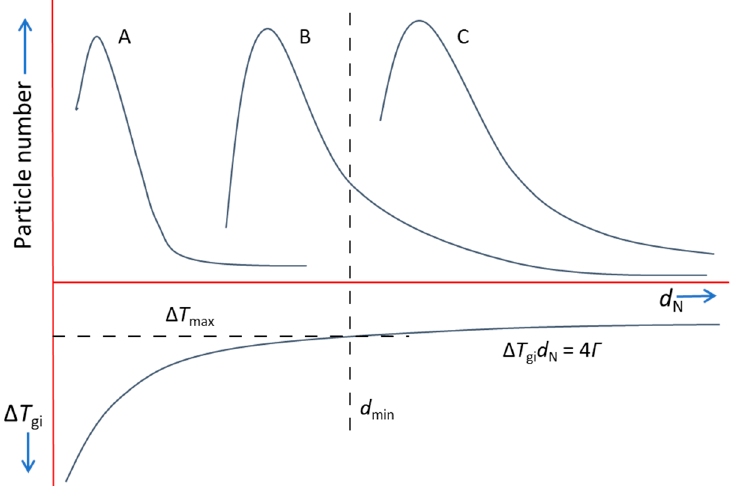
Figure 9. Schematic illustration of the competition for grain initiation between three different types of nucleant particles (denoted as A, B and C), with their unique size distributions. We assumed that all three types of particles have participated in nucleation. d min is the minimum solid particle size determined from the maximum undercooling ( ∆ T max